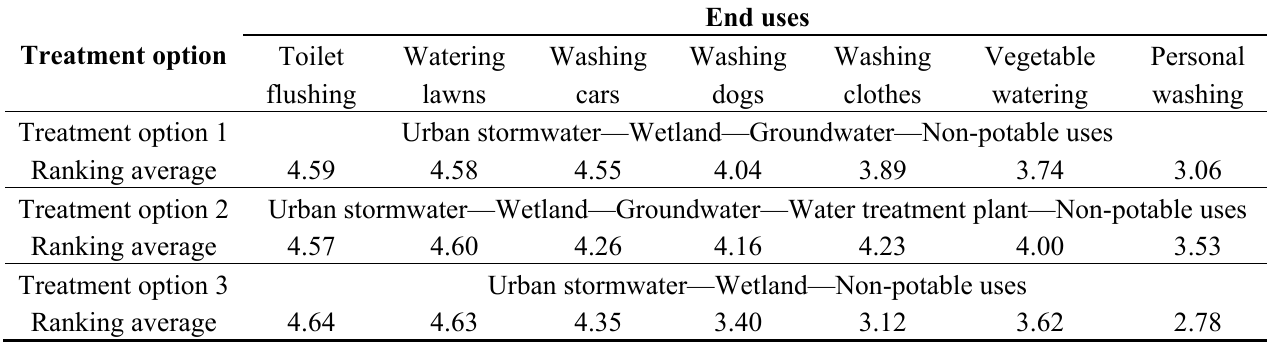
Table 4. Respondents’ preferences to different treatment options of